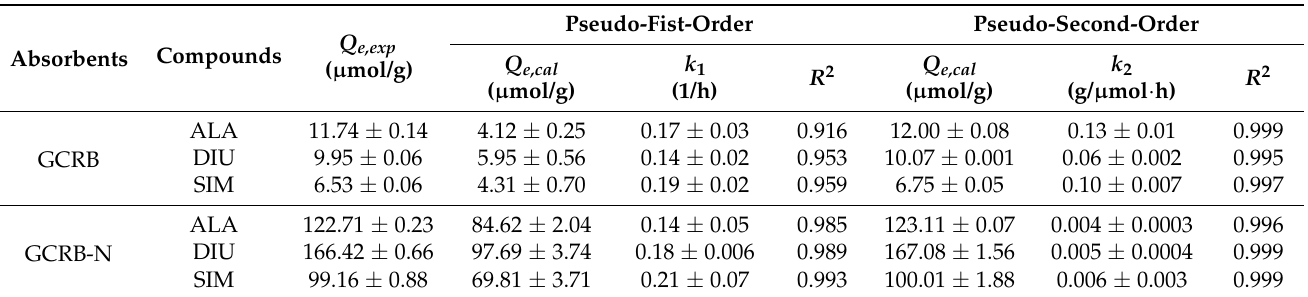
Table 3. Kinetic parameters for the adsorptions of herbicides using the GCRB and GCRB-N (agitation speed = 150 rpm,